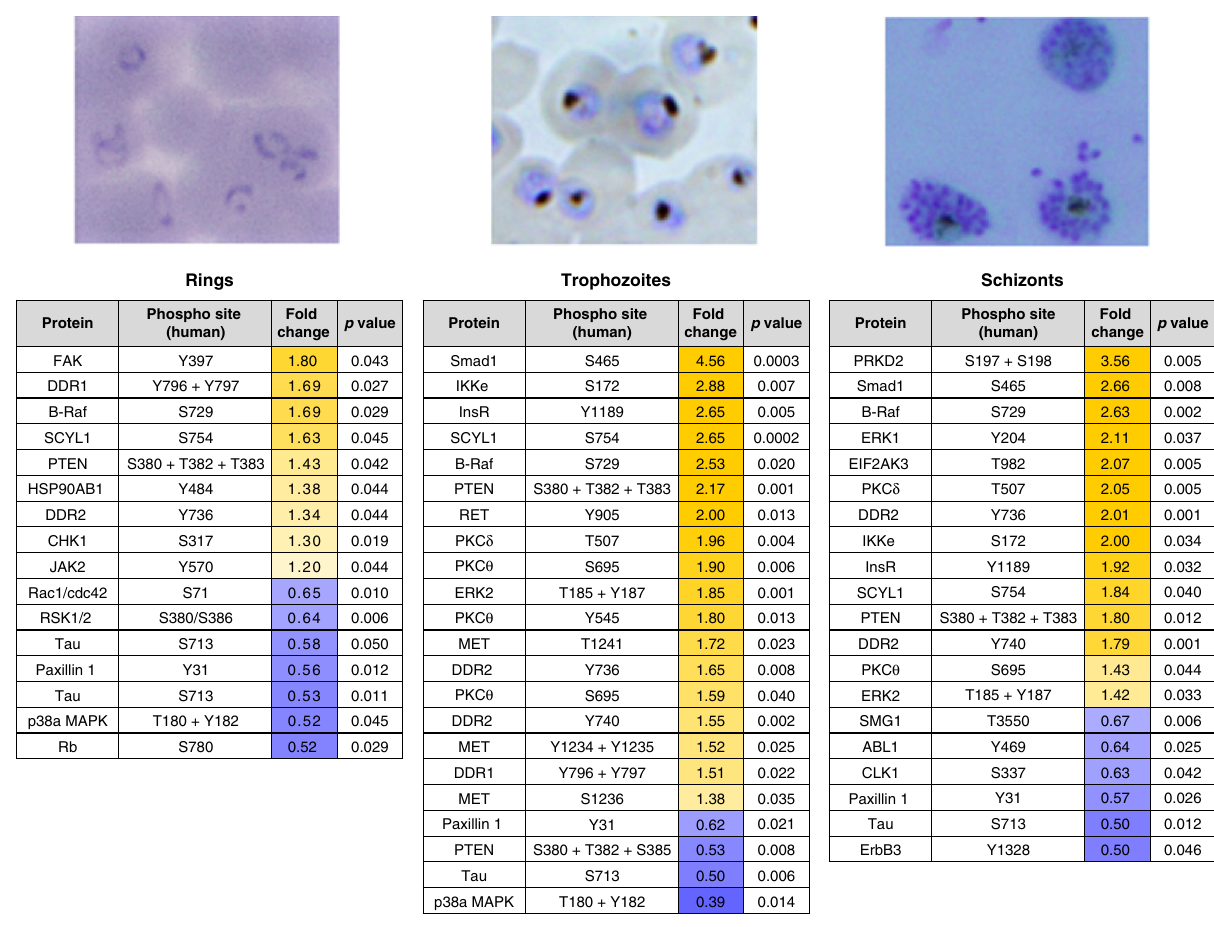
Fig. 3 Shortlist of the highest con fi dence signals ( p < 0.05) for rings, trophozoites and schizonts. Increases in phosphorylation compared to uninfected erythrocytes are marked in yellow; decreases are marked in blue. All values listed are the fold change from the uRBC control mean ( n = 4 biologically independent samples); the corresponding p -value for each signal is also listed. Each signal has a p -value < 0.05, as determined through an unpaired two- tailed T -test. All listed signals passed stringent parasite cross-reactivity and signal intensity fi lters (see text for details and Fig.